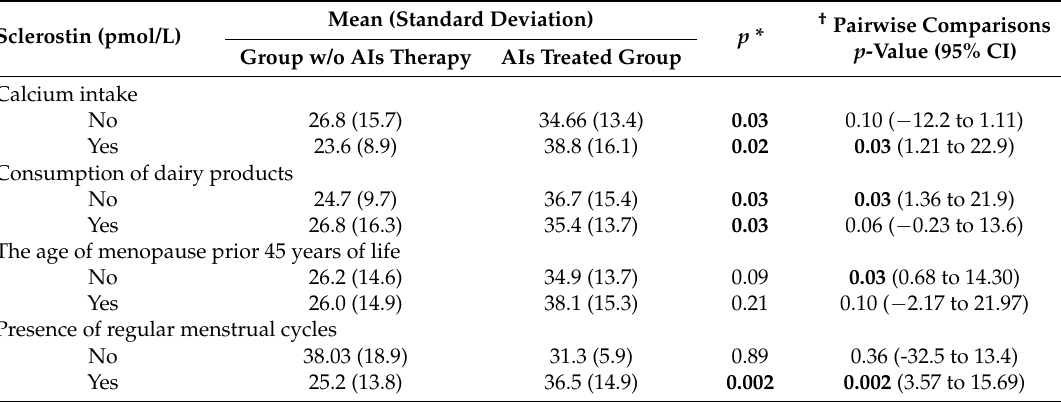
Table 2. Differences in serum levels of sclerostin according to the examined lifestyle parameters between the AI-treated and AIs non-treated group of patients (adjusted for smoking, vitamin D intake, exercise and exercise in the youth).